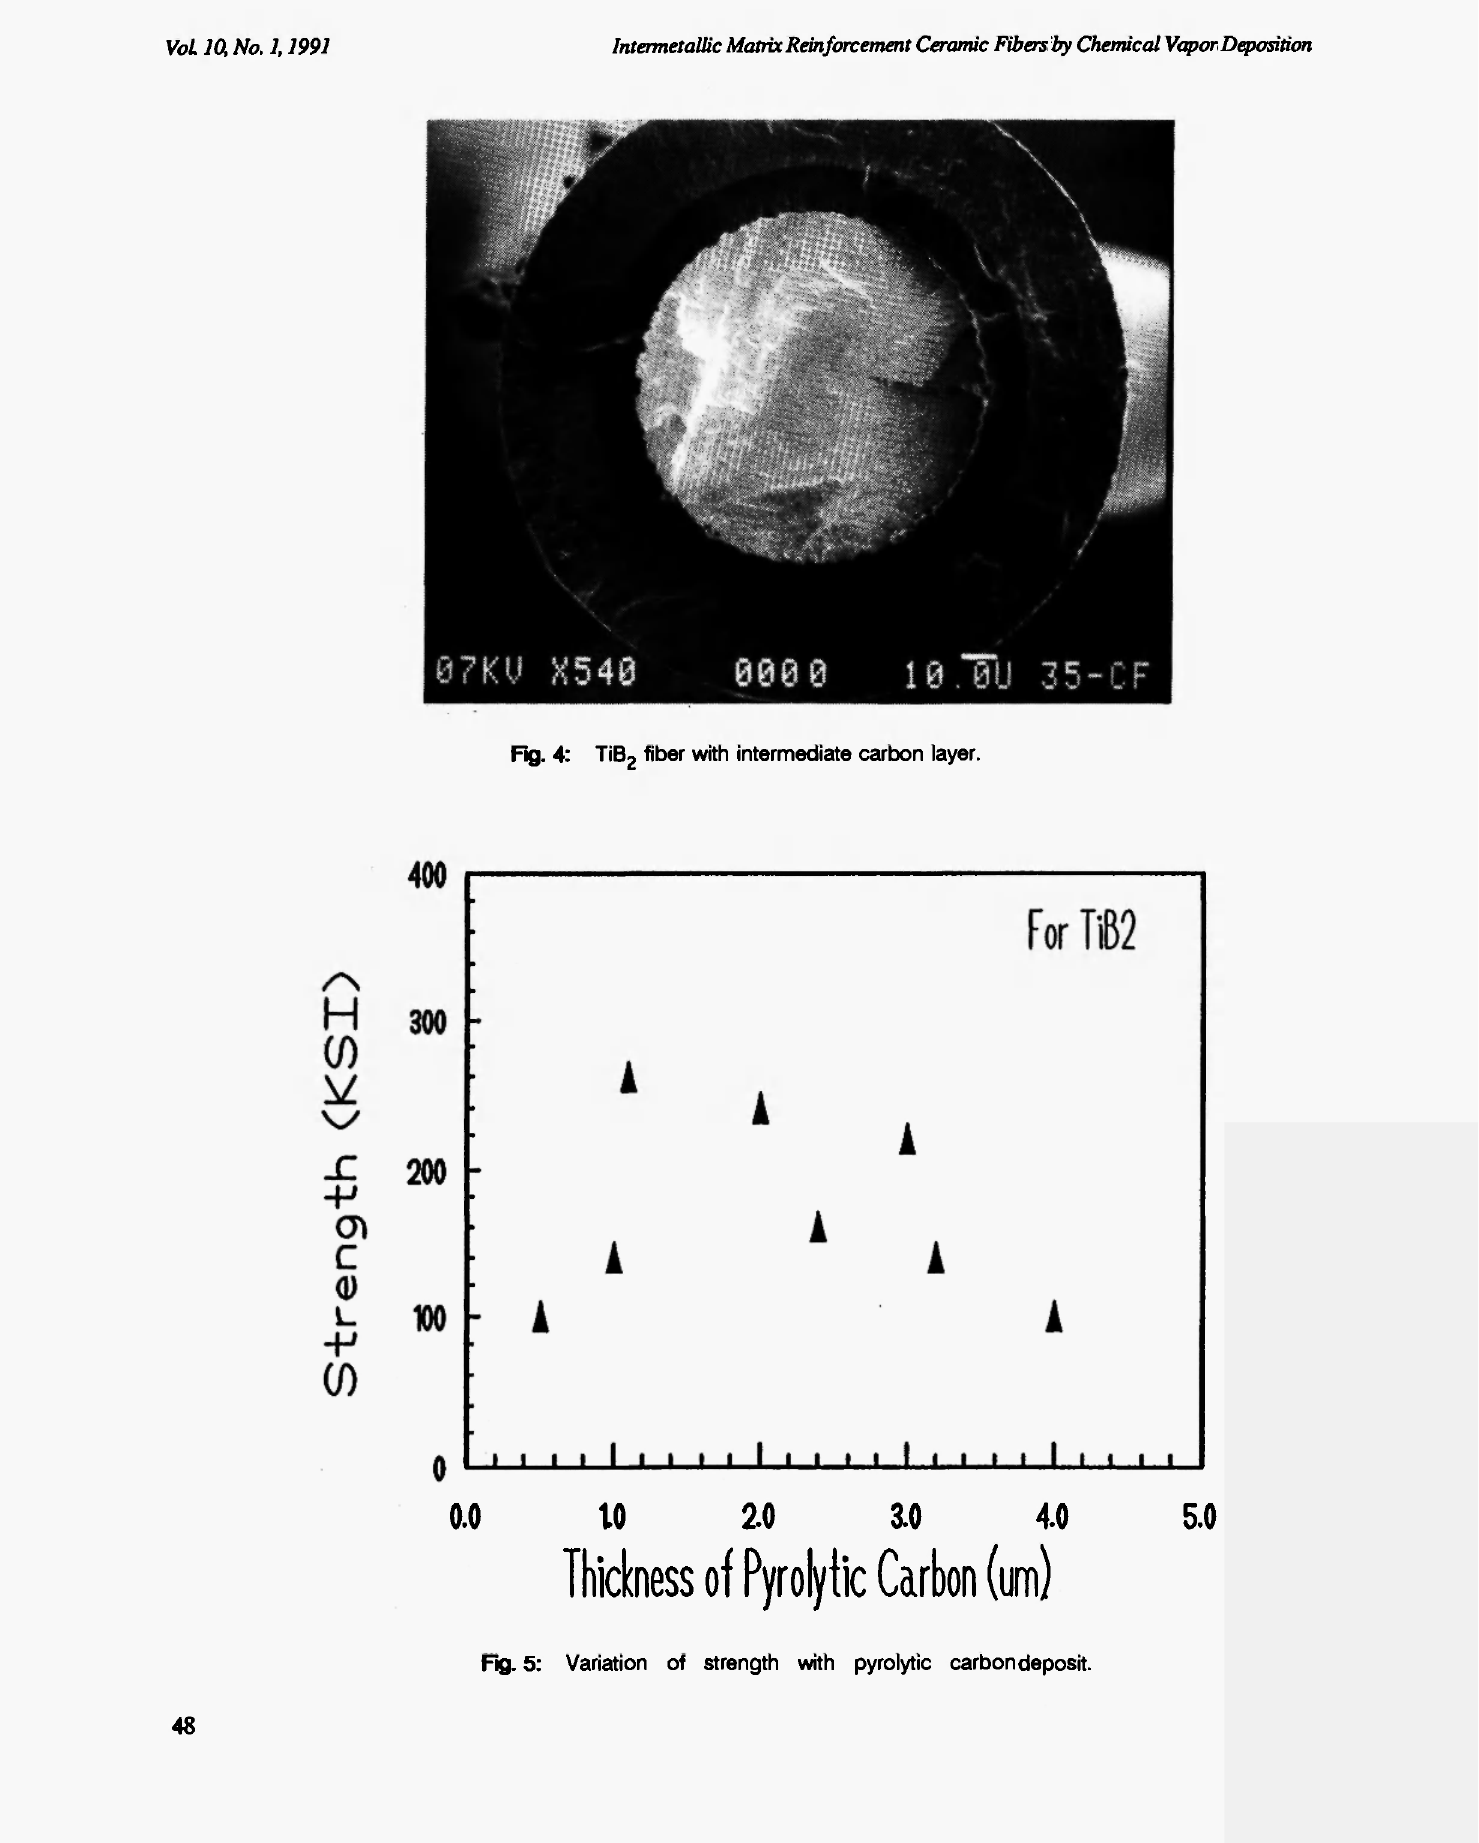
Fig. 5: Variation of strength with pyrolytic carbon